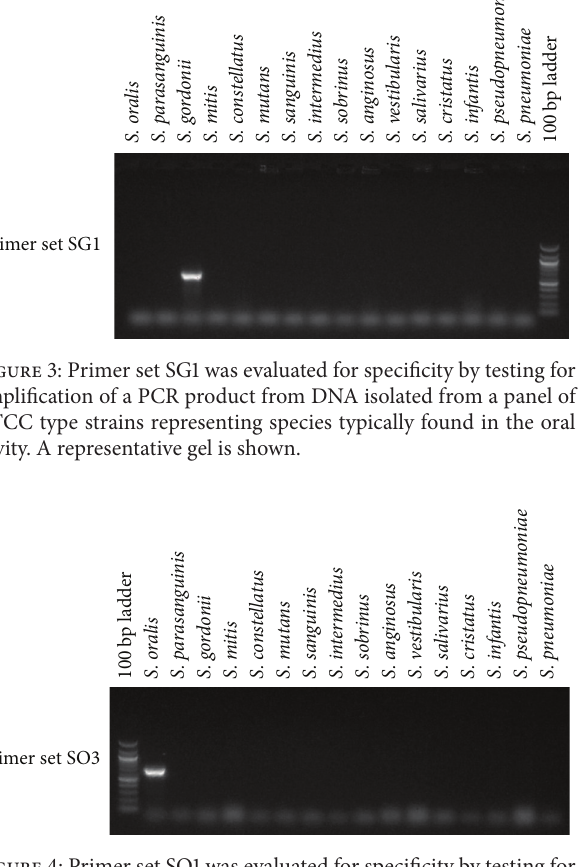
Figure 4: Primer set SO1 was evaluated for specificity by testing for amplification of a PCR product from DNA isolated from a panel of ATCC type strains representing species typically found in the oral cavity. A representative gel is shown.